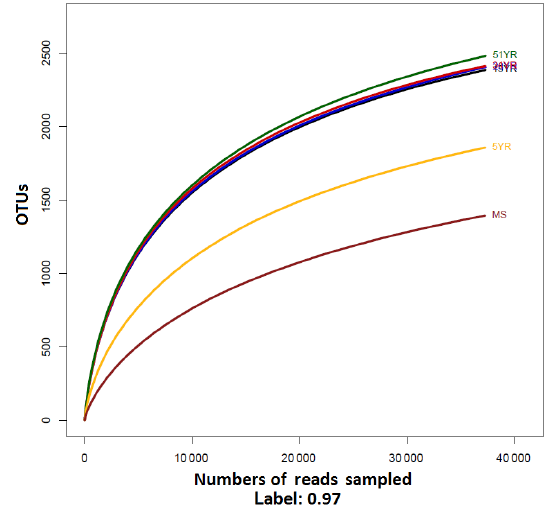
Figure 2. Rarefaction results of the 16S rDNA libraries based on 97% similarity in different age of BSCs. MS, 5YR, 15YR, 28YR, 34YR and 51YR represent mobile sand, 5-, 15-, 28-, 34- and 51- year-old BSCs,